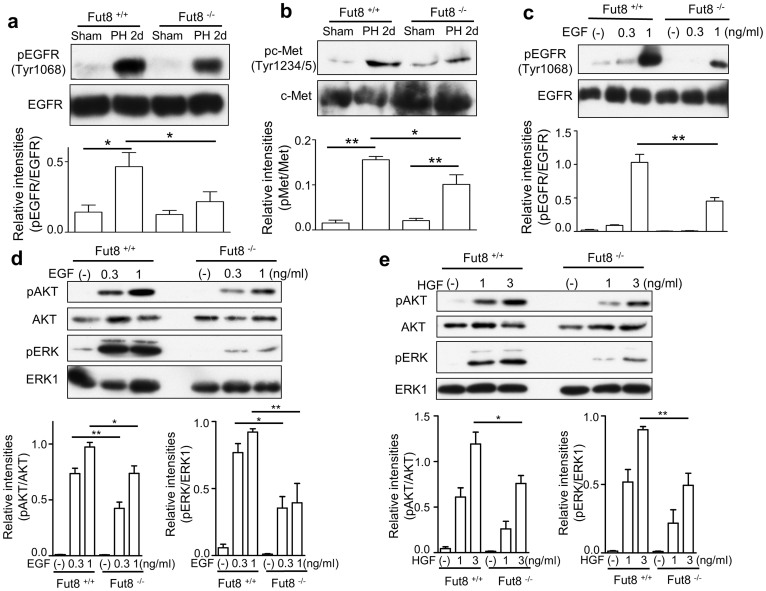
Intracellular signaling was suppressed in Fut8−/− mice upon either PH or EGF and HGF stimulation.8-week-old Fut8+/+ or Fut8−/− mice were surgically resected as described in “Methods”, and then the livers were harvested at 2 days. The liver homogenates were separated by 7% SDS-PAGE and blotted with anti-EGFR and anti-phospho-EGFR antibodies (a), and anti-c-Met and anti-phospho-c-Met antibodies (b). The quantitative data were obtained from 3 mice in each group. *, P < 0.05, **, P < 0.01. The primary hepatocytes isolated from 8-week old Fut8+/+ and Fut8−/− mice were cultured in DMEM containing with 10% FBS for 12 h, and then cultured under DMEM containing with 0.1% FBS for 24 hours. After the starvation, these cells were stimulated with or without EGF at indicated concentrations for 5 min (c and d), or HGF at indicated concentrations for 10 min (e). The cell lysates were immunoblotted with anti-pEGFR and anti-EGFR, anti-pAKT and anti-AKT antibodies, anti-pERK and anti-ERK1 antibodies. The quantitative data were obtained from at least 3 independent experiments, *, P < 0.05, **, P < 0.0 1.